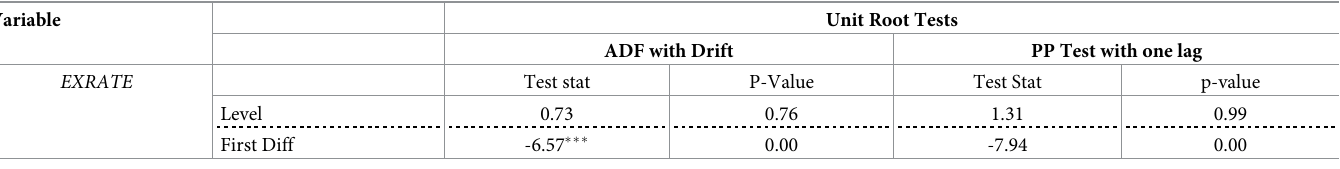
Table 2. Stationarity test of average USD/LKR exchange rate.